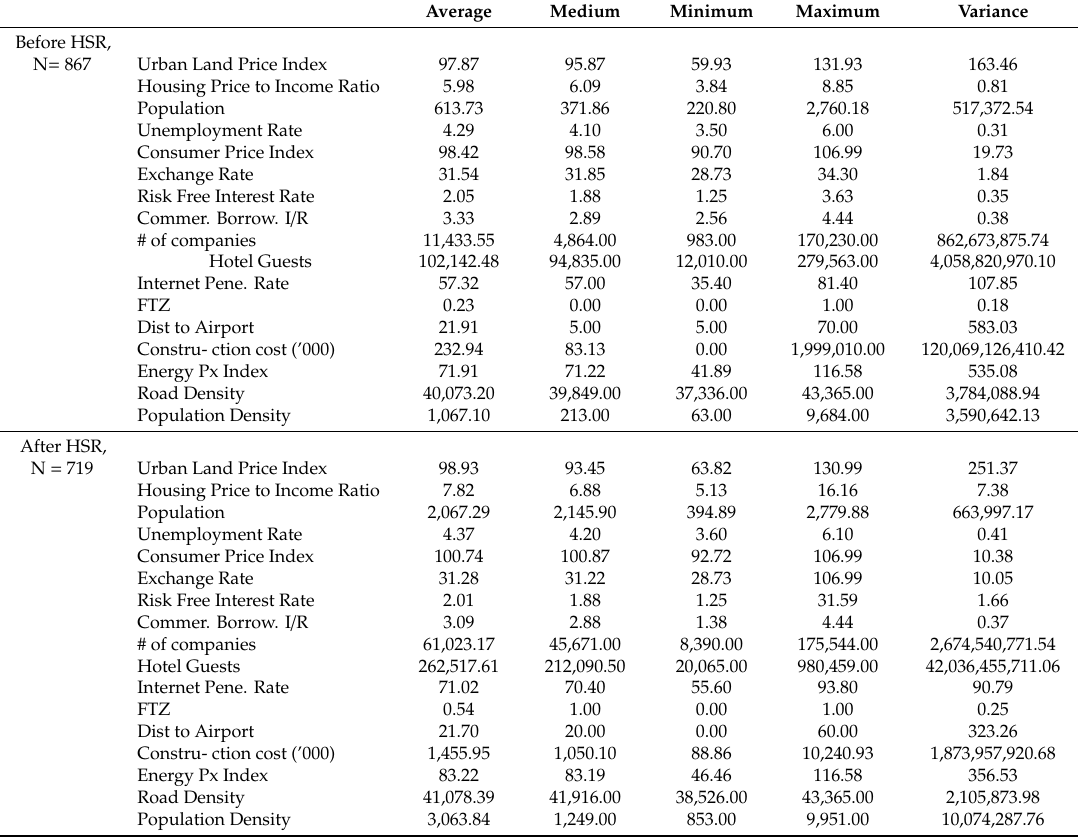
Table 3. Descriptive statistics of data set before and after the introduction of